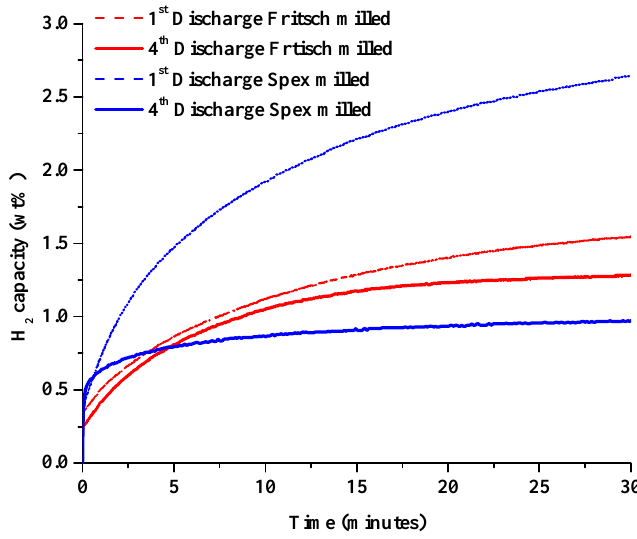
Figure 5. Hydrogen desorption curves at standard desorption conditions during first and fourth isothermal discharge cycles of the unmodified material.